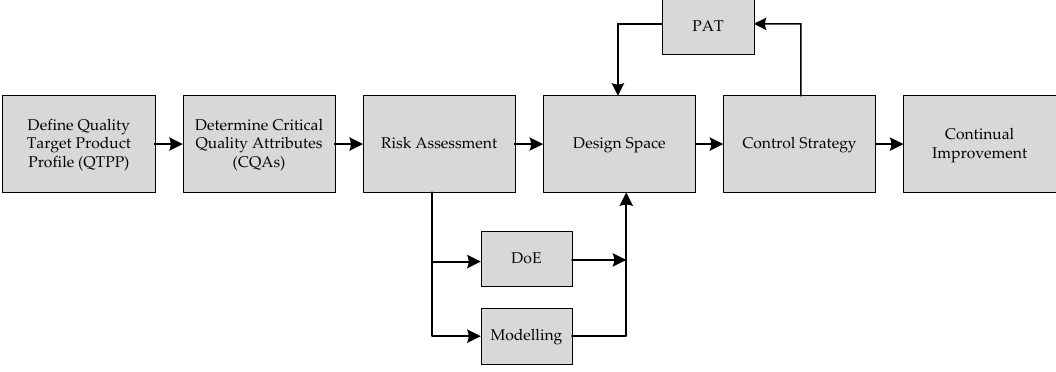
Figure 1. The Quality-by-Design (QbD)-approach to quality assurance [13], PAT process analytical technology, DoE design of experiments.